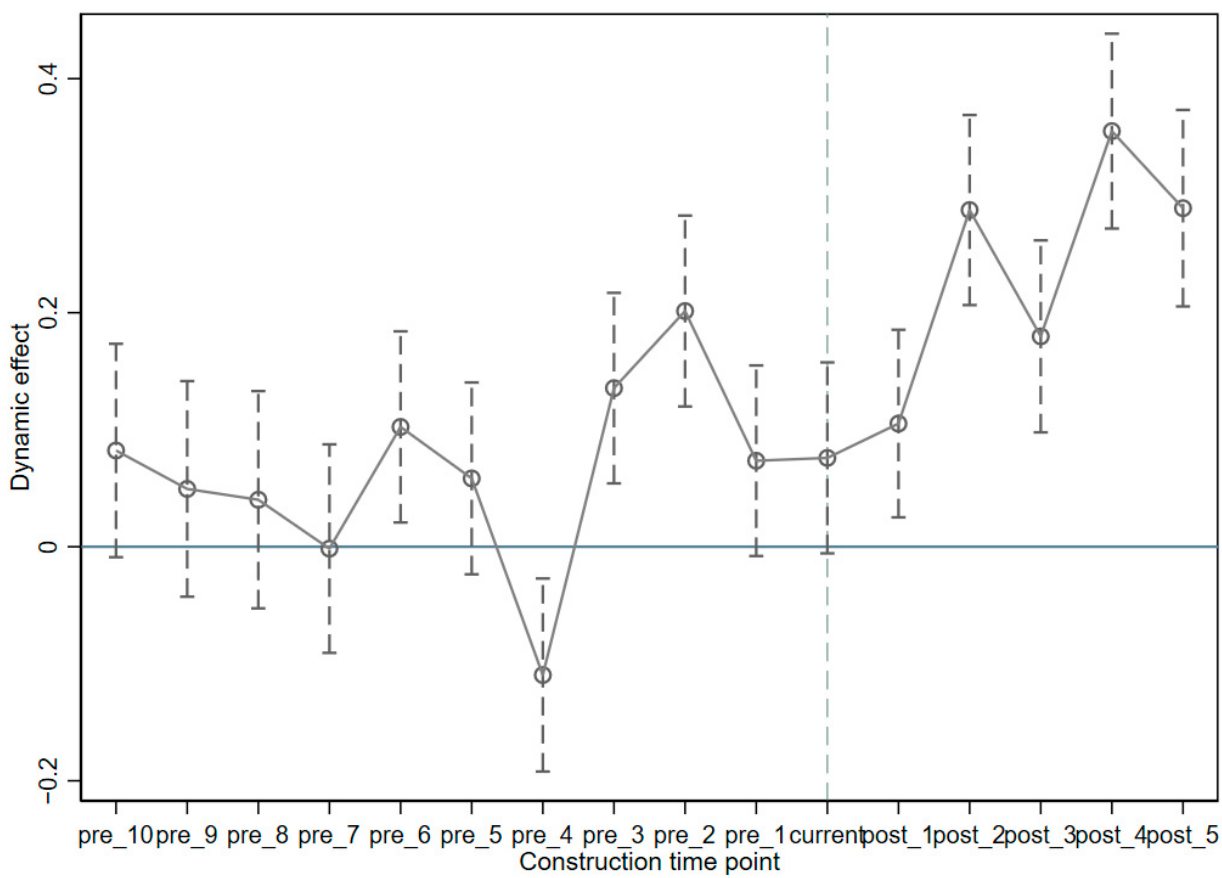
Figure 4. DID parallel trend test. Table 3. DID parallel trend test based on the fixed effect model.